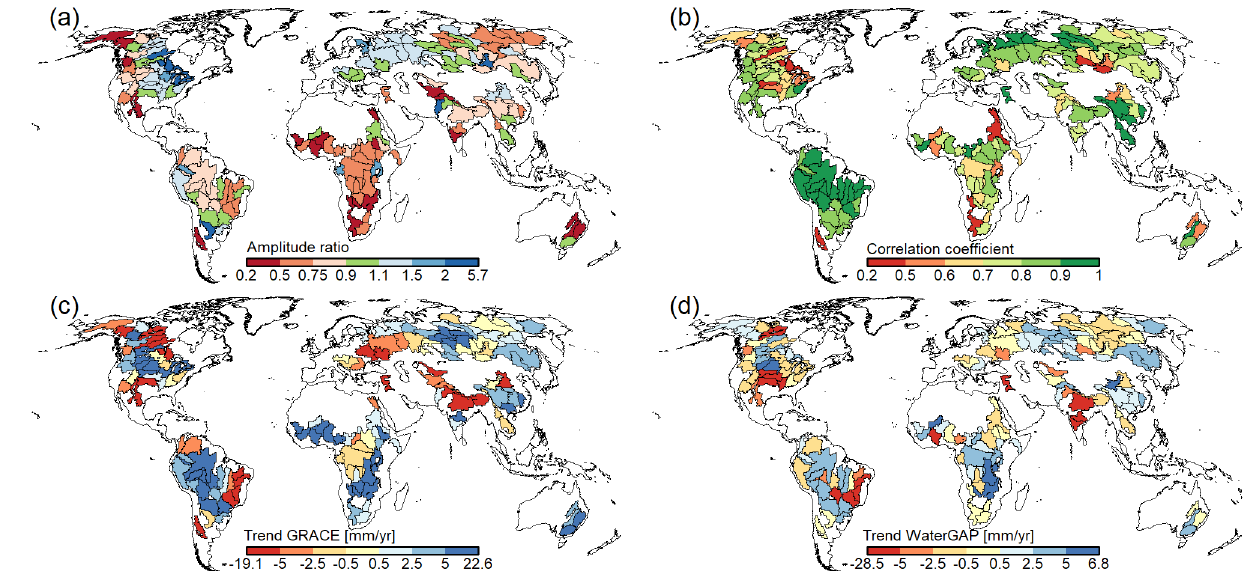
Figure 9. Comparison of basin-average TWSAs of WaterGAP 2.2d and the average values of three GRACE mascon products for 143 basins larger than 200000km 2 , with (a) ratio of amplitude (reddish colors indicate underestimated amplitude of WaterGAP, vice versa for bluish), (b) correlation coefficient, (c) trend of GRACE and (d) trend of WaterGAP 2.2d. All values based on the time series January 2003– December 2015.